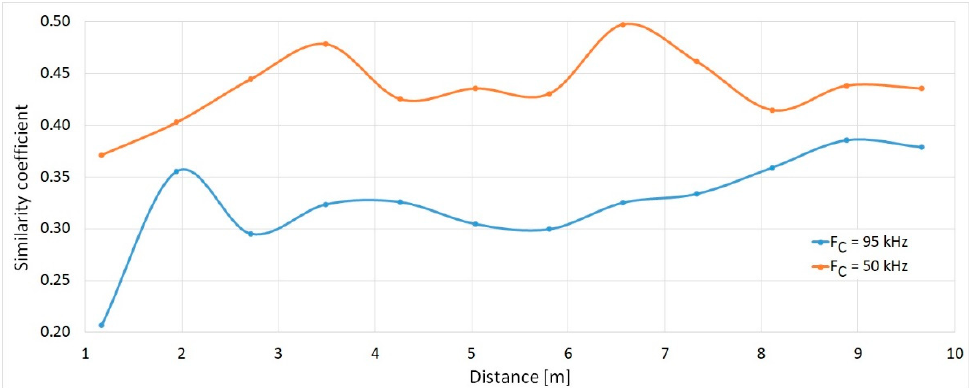
Figure 5. Measured similarity coefficients as a function of the distance from the receiver for the band 𝐵 = 10 kHz and chirp duration 𝑇 = 30 ms at the transmitter velocity 𝑉 = 1 m/s . B = 10 kHz and chirp duration T = 30 ms at the transmitter velocity V = 1 m/s.